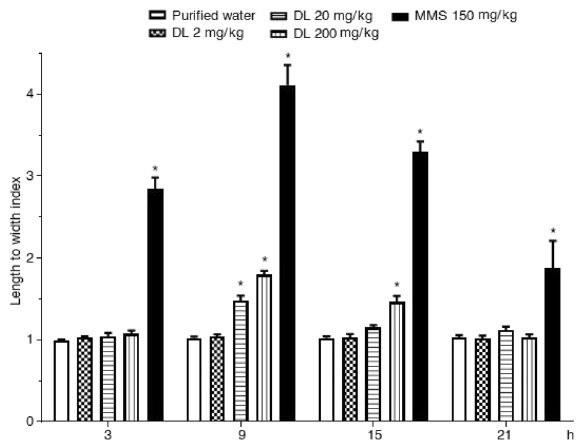
Figure 1. Mouse brain cells exposed to duloxetine (DL) and methyl metanesulfonate (MMS). Evaluation with the comet assay along 21 h after a single administration. Each bar represents the mean ± SEM of 5 mice per group. 100 nucleoids per animal. *Statistically significant difference with respect to control value. ANOVA and post hoc Student–Newman–Keuls tests ( p ≤ 0.05).